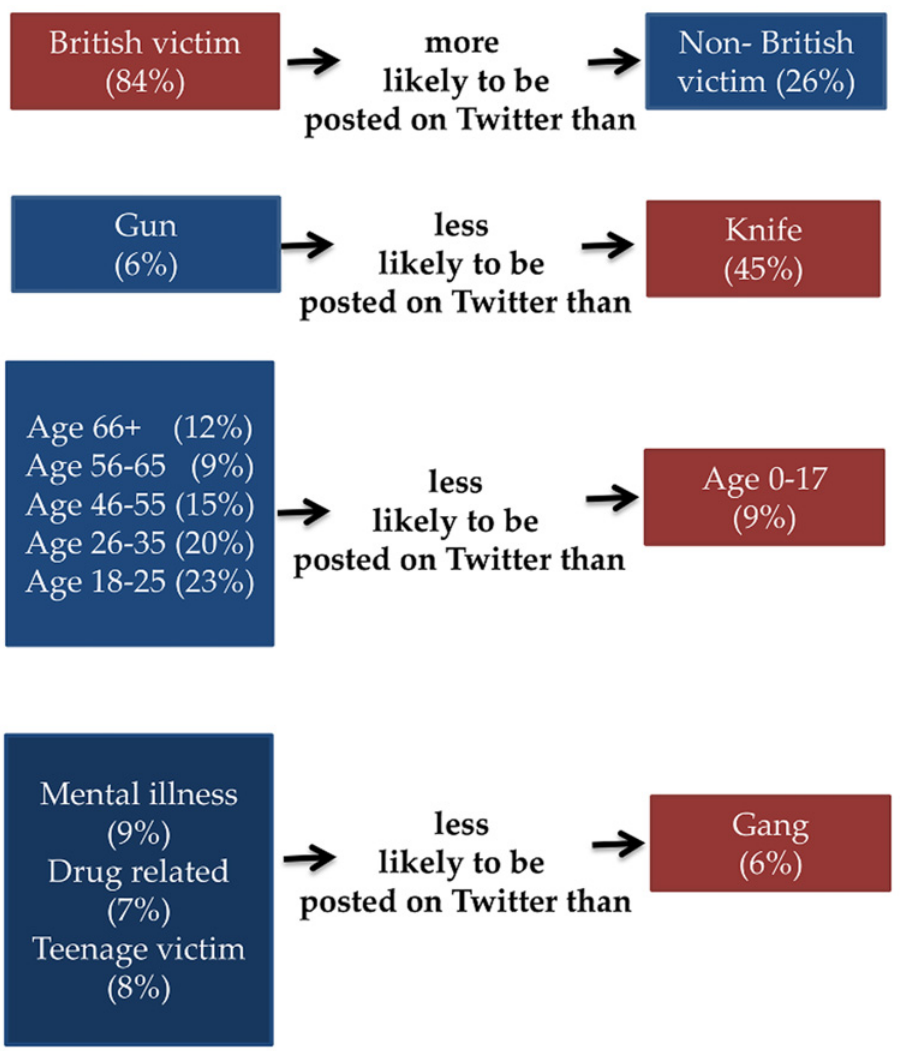
Fig 8. Posting likelihood on Twitter by category of the explanatory variable. Likelihood is expressed as odds, namely the likelihood of an event occurring to the likelihood of not occurring. Blue rectangles indicate categories of lower posting likelihood compared to the categories in red rectangles. The percentages in parenthesis show the frequency of this category in the Homicide-Dataset .